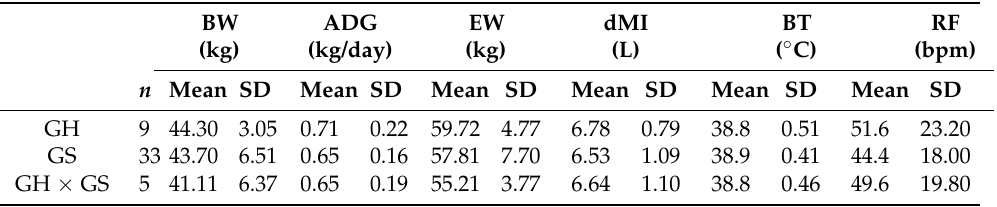
Table 1. Descriptive statistics for birth weight, average daily weight gain, body temperature, and res- piratory frequency per breed